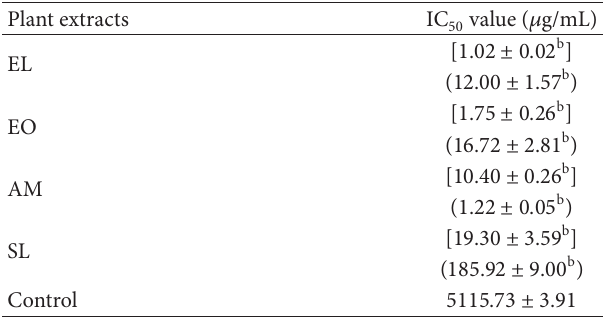
Table 3: IC values ( 𝜇 g/mL) of methanolic and aqueous plants 50 extracts that actively inhibit 𝛼 -glucosidase. Plant extracts